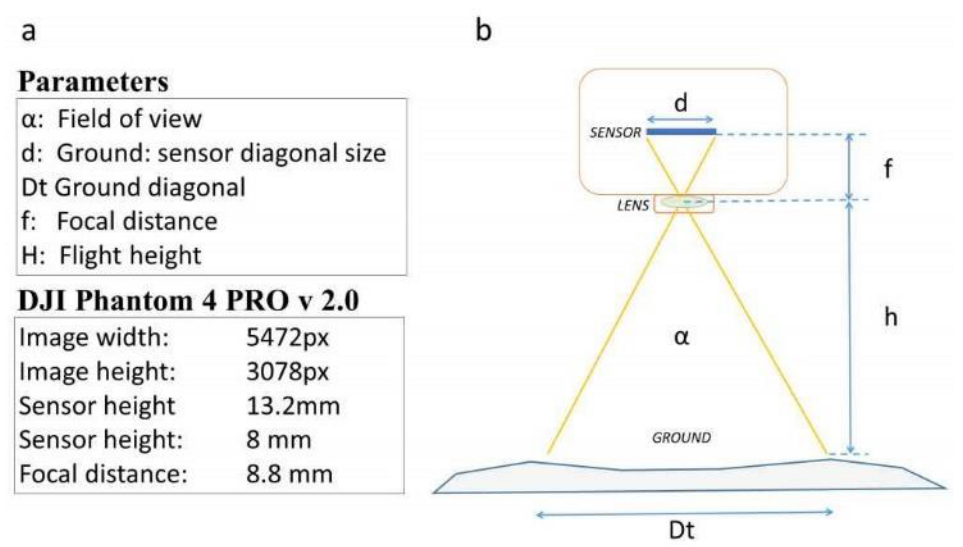
Figure 2. ( a ) Sensor characteristics of the DJI Phantom 4 PRO v 2.0; ( b ) parameters for calculating the distance of the sample to the ground: sensor diagonal size ( d ), focal distance ( f ), field of view ( α ), ground diagonal (Dt), and vertical ground distance or flight height ( h ). With this choice, a spatial resolution of 0.01 – 0.03 m was obtained, which was sufficient to recognize the smallest macro beached marine litter (BML).